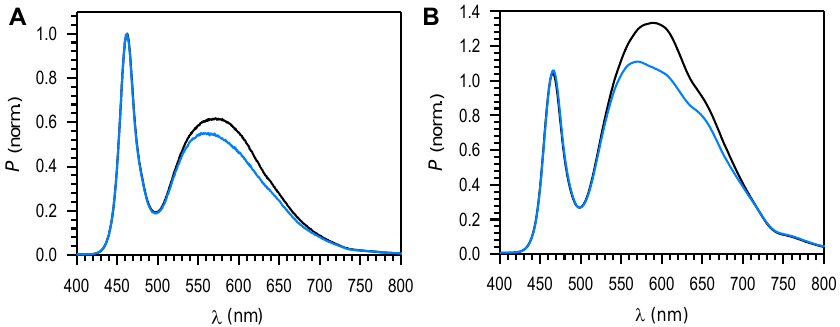
Figure 6. Normalized transmission spectra at 455 nm of two PMMA fiber cores before (black line) and during their exposure to a 2.7 mg L ⁻ 1 methylene blue solution (blue line). ( A ) PMMA optical fiber subjected to a chemical dissolution process to remove its cladding for 45 min. ( B ) 3D printing PMMA filament. Acquisition parameters: 36 ms ( A ) and 100 ms ( B ) exposure times; boxcar 7; 10 scans per spectrum.